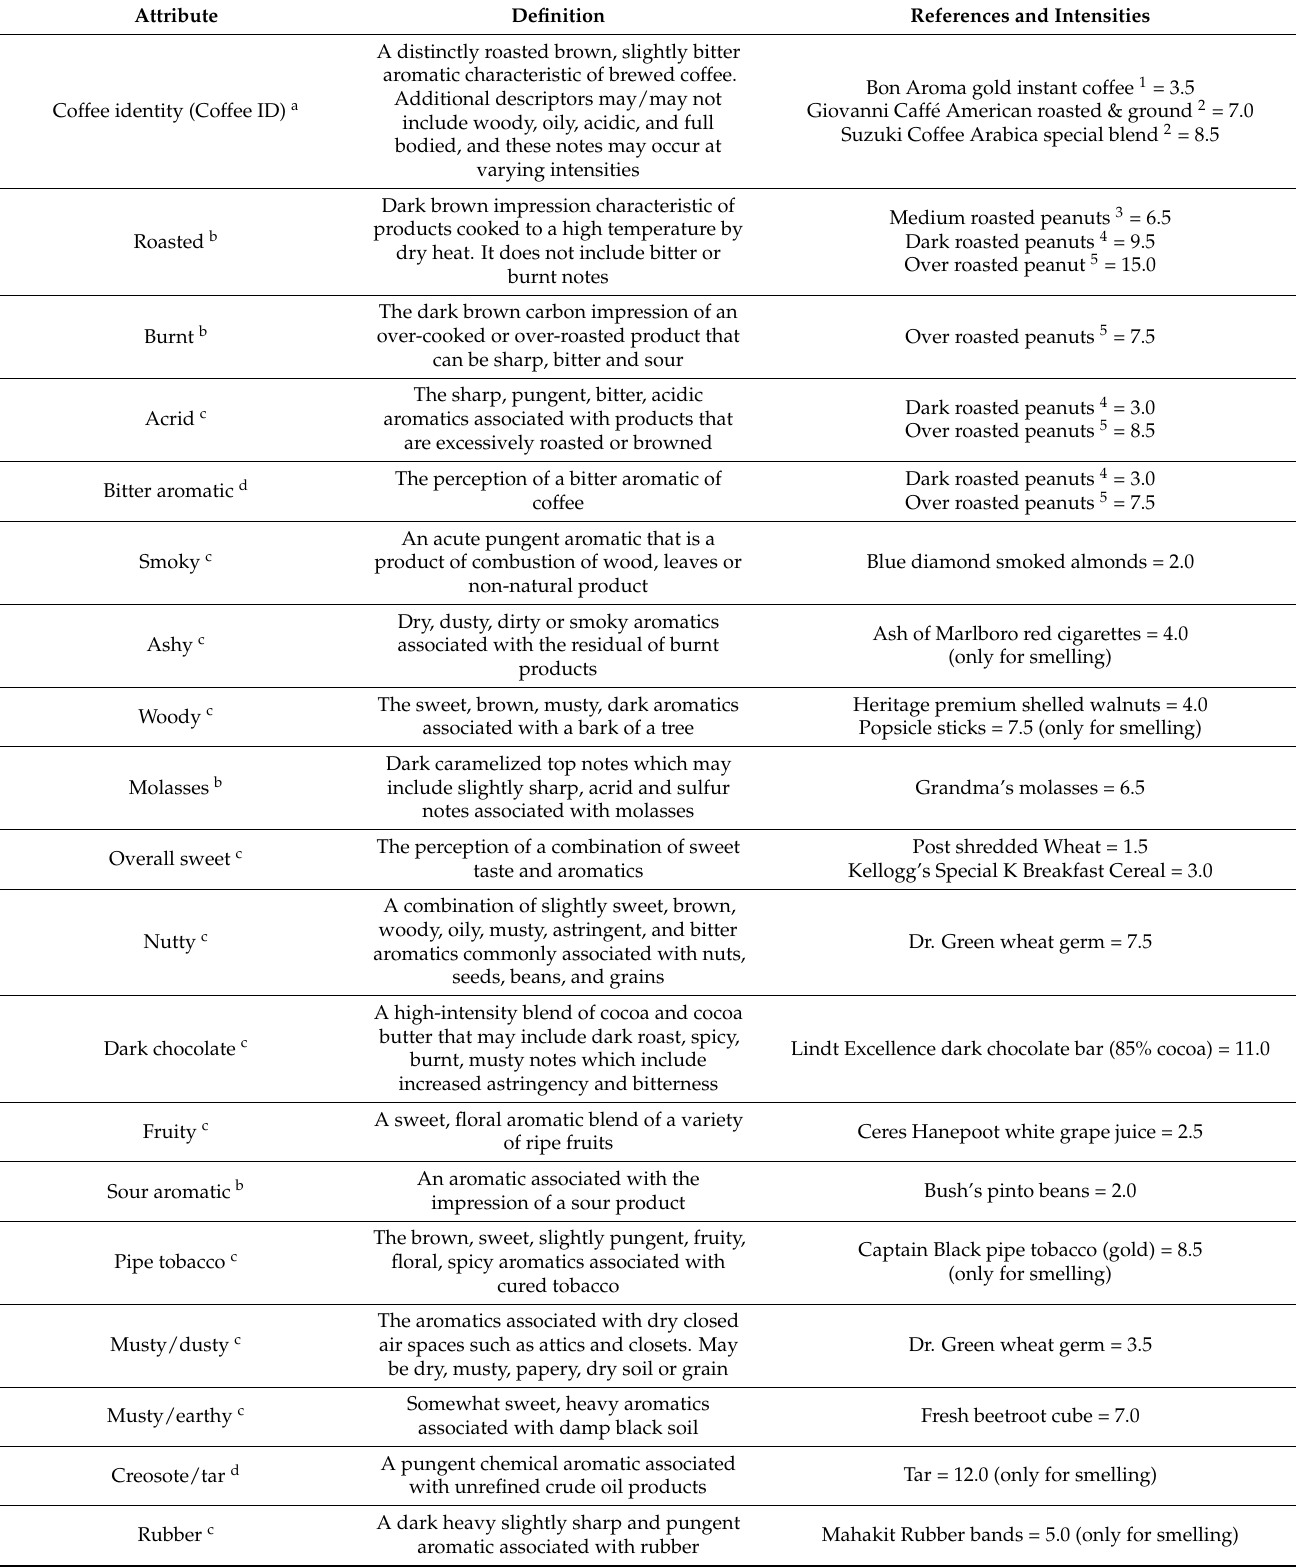
Table 3. Sensory attributes, definitions and references for brewed black coffee